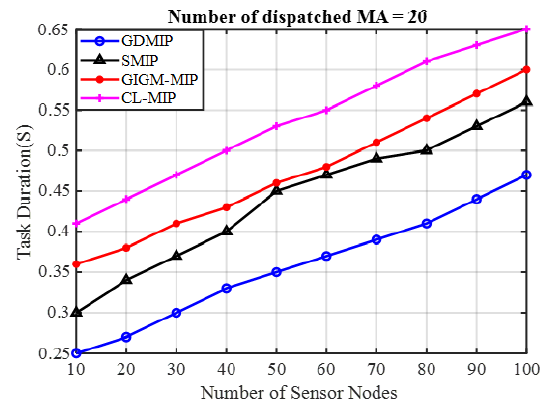
Figure 7. The Impact of the Number of Dispatched MAs on Task